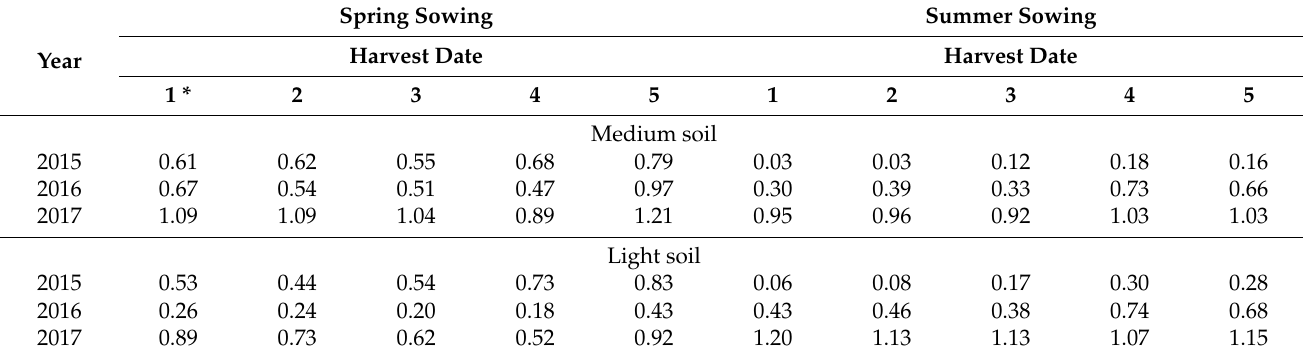
Table 2. Hydrothermal Sielianinov index ( K ) during the quinoa growing